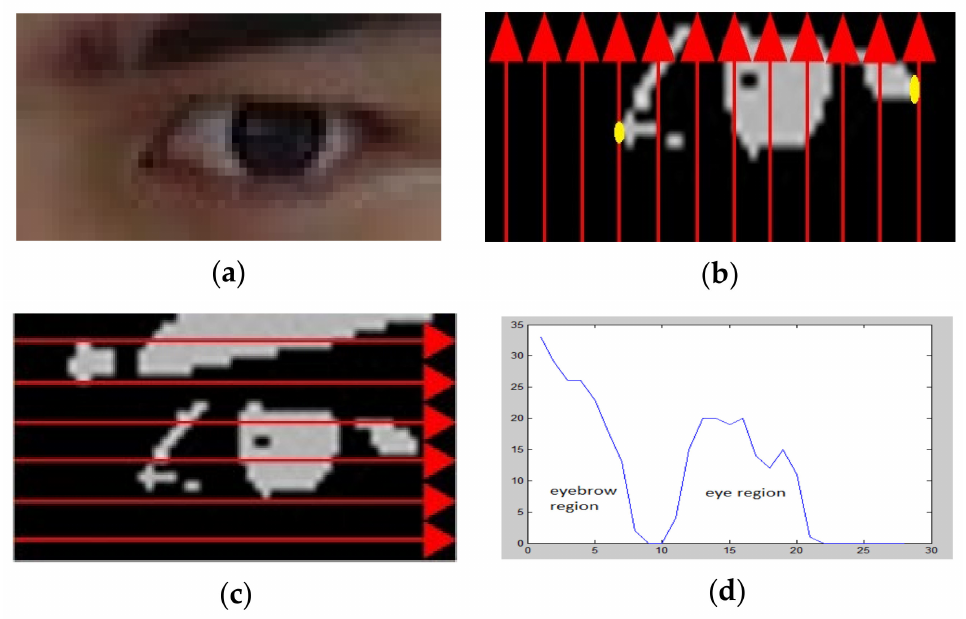
Figure 4. Projection technique to find landmarks of eye; ( a ) extracted eye ROI; ( b ) vertical projection; ( c ) horizontal projection; ( d ) projection data of ( c